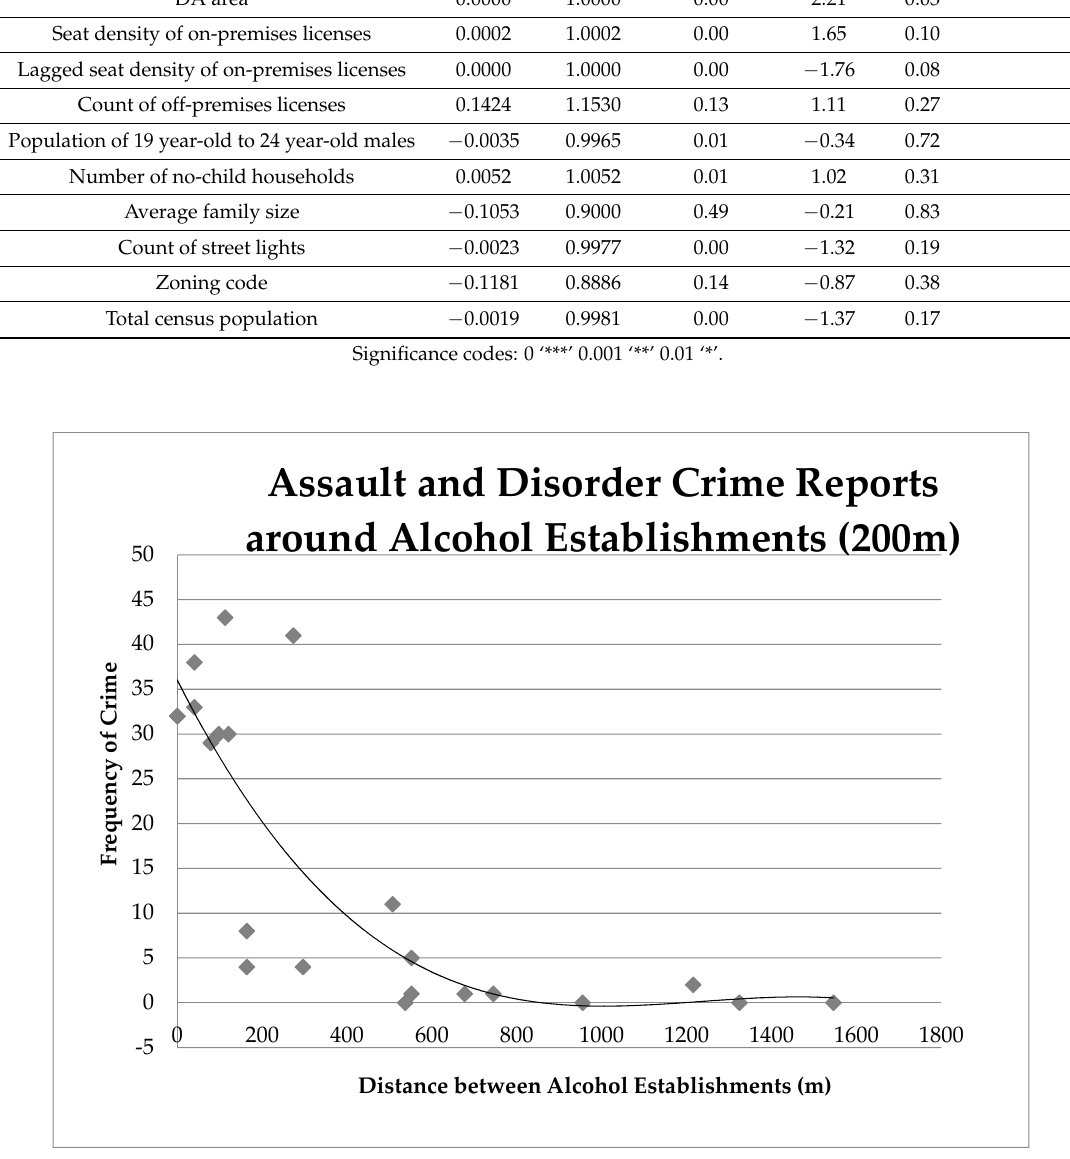
Figure 4. Influence of bar and pub proximity (distance in meter) on the frequency of assault and disorder crime around bars and pubs.